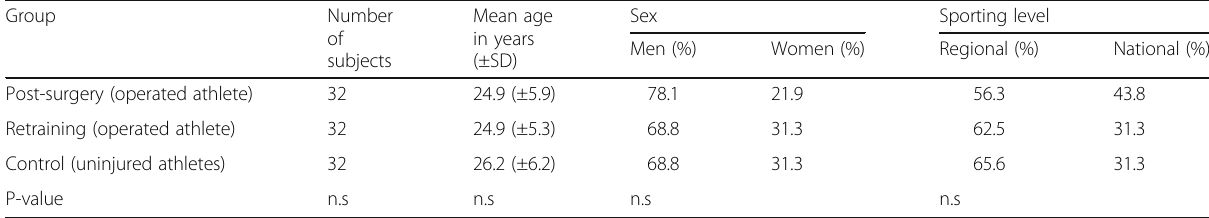
Table 1 Socio-demographic descriptive characteristics of athletes